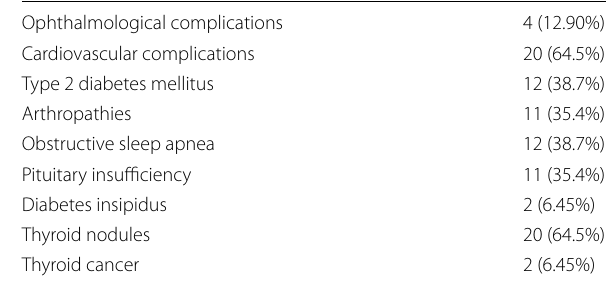
Table 1 General characteristics of the included sample